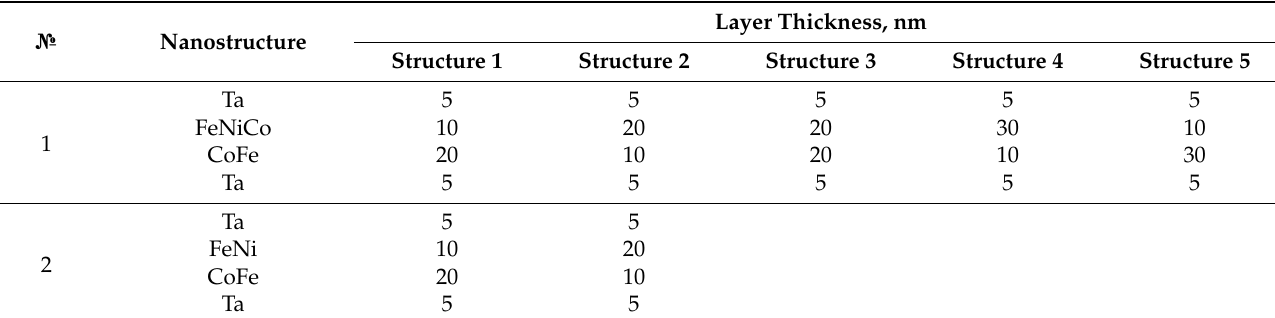
Table 1. Parameters of the studied